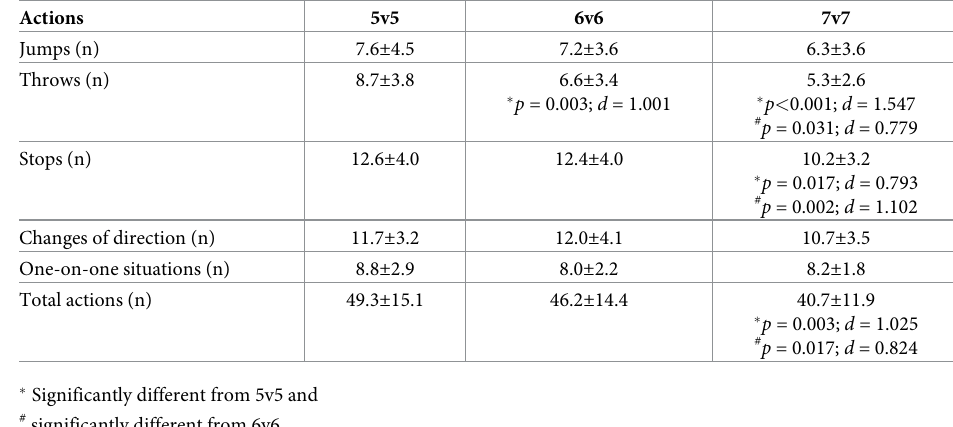
Table 3. Players’ high-intensity game actions (data are presented as means ± SD) during 5v5, 6v6 and 7v7 recrea- tional team handball game